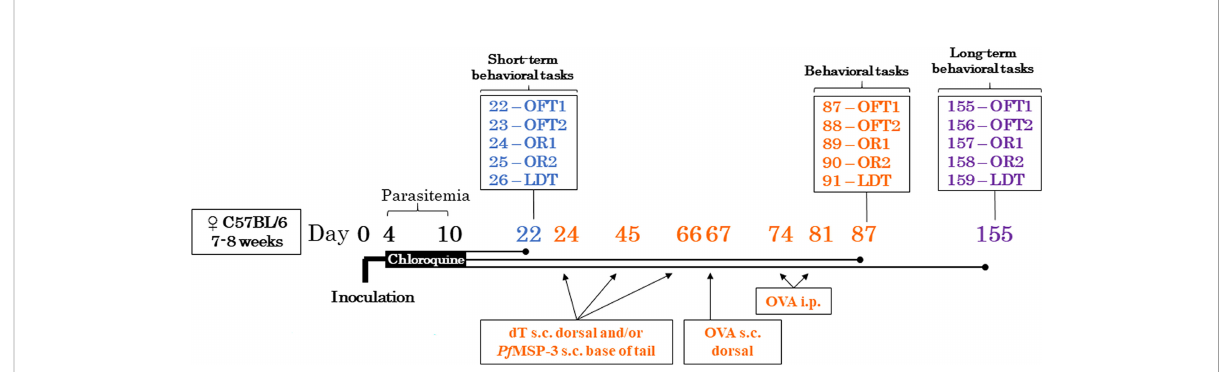
FIGURE 1 Experimental design. C57BL/6 mice were infected with 10 6 parasitized red blood cells with Plasmodium berghei ANKA on day 0 or injected with the vehicle (PBS control) intraperitoneally. Four days post infection, both mice were treated with chloroquine 25mg/kg via gavage for seven days and parasitemia was measured at the beginning and end of treatment, and after behavioral assays. To assess the evolution of cognitive- behavioral performance, cohorts of control (CTRL) and infected (INF) mice were evaluated 12 (cohort 1) and 145 (cohorts 2 and 3) days after the end of treatment in behavioral tests. To evaluate the immunomodulatory effect, control and infected mice were immunized or not with the dT vaccine immunization strategy. For comparative purposes, a group of infected mice was immunized with the type 2 immune response pro fi le immunization strategy. All mice were evaluated in behavioral tests; PfMSP-3 – Plasmodium falciparum Merozoite Surface Protein 3, dT vaccine – diphtheria-tetanus vaccine, OVA – white chicken egg ovalbumin, s.c. – subcutaneous, i.p. – intraperitoneal; OFT – open fi eld test, OR1 – object recognition 1 (training session), OR2 – object recognition 2 (test session), LDT – light/dark